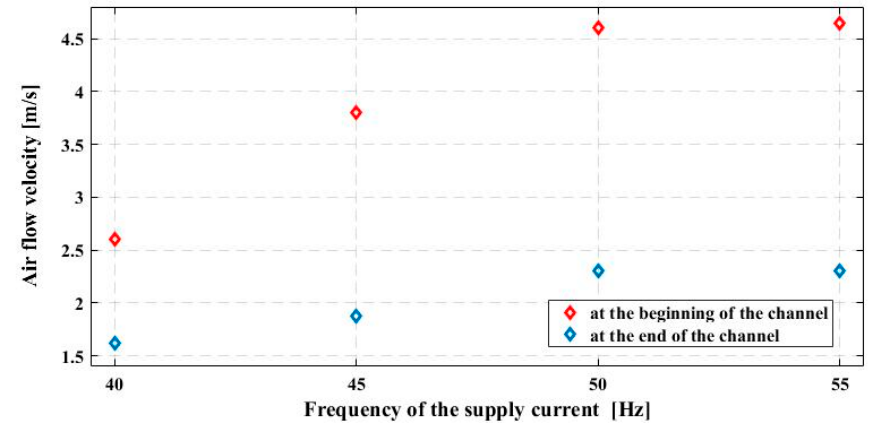
Figure 3. Air flow velocity at the channel beginning/end.